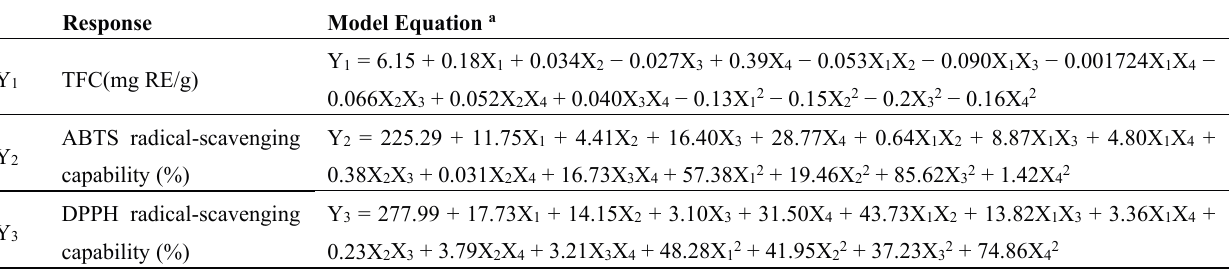
Table 2. Regression models fitted to the experimental data of response variables. Response Model Equation a